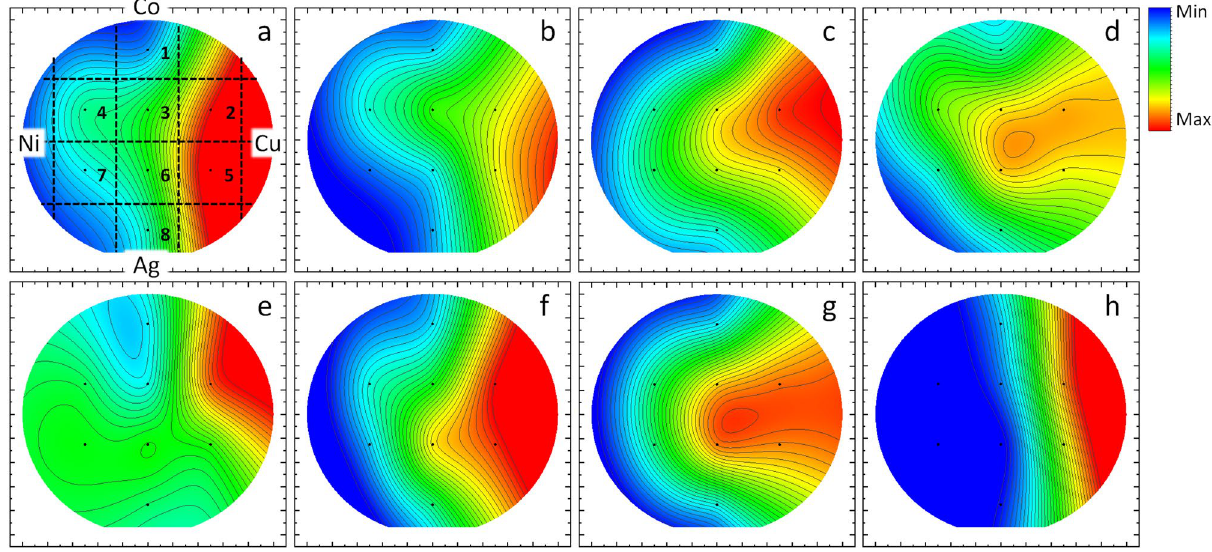
Figure 5. Heat map of log-reduction on the thin film chips of ( a ) Phi6, ( b ) MS2, ( c ) E. coli , and ( d ) B. subtilis ; log-reduction on the annealed chips of ( e ) Phi6, ( f ) MS2, ( g ) E. coli , and ( h ) B. subtilis.